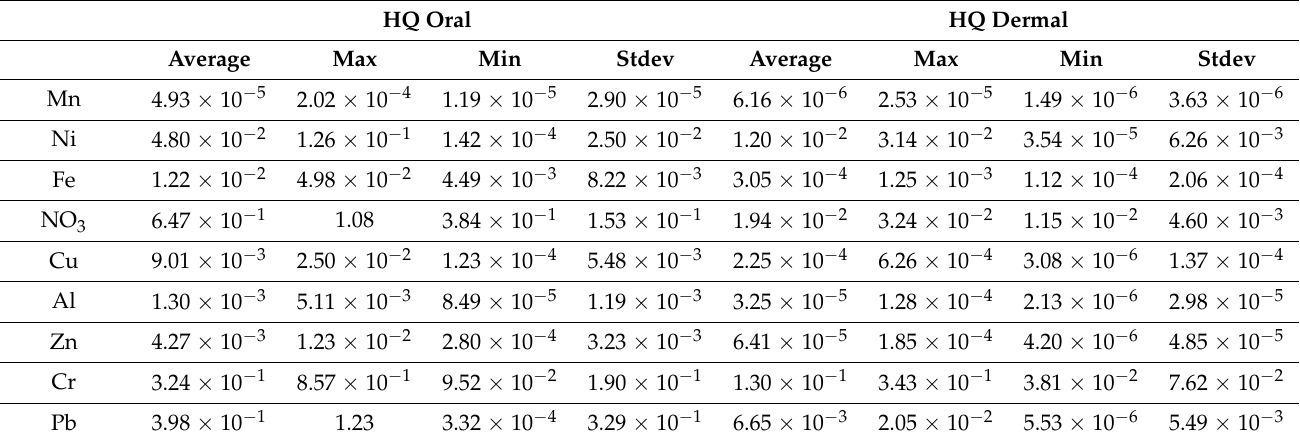
Table 6. HQ values of NO 3 and metals in T â rgovi¸ste Plain. HQ Oral HQ